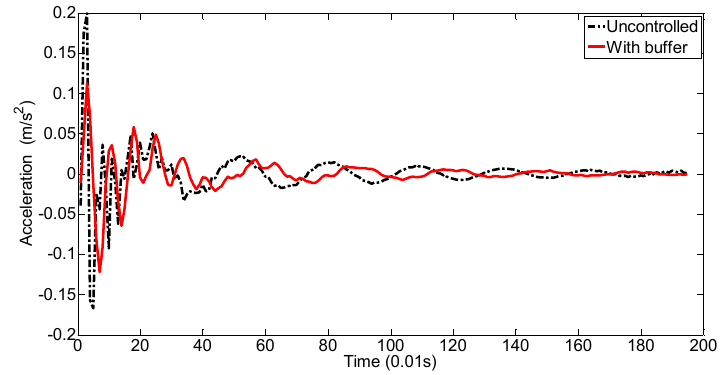
Figure 4. Time history curves of structure with/without a lateral damping buffer (grade 7).